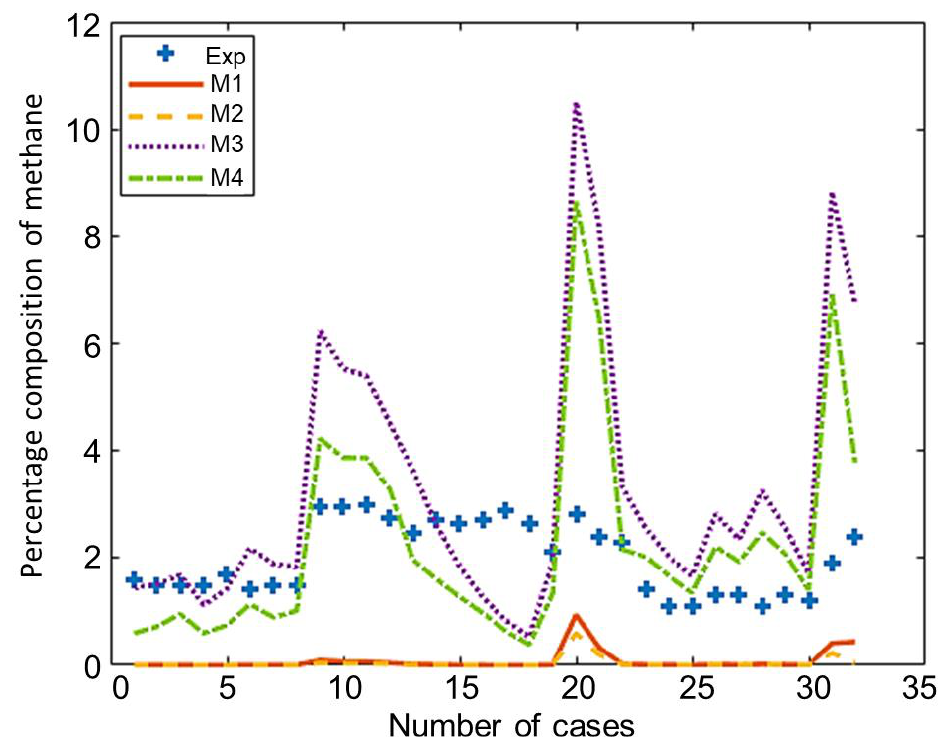
Figure 6. Comparison of methane composition given by experiments and models.